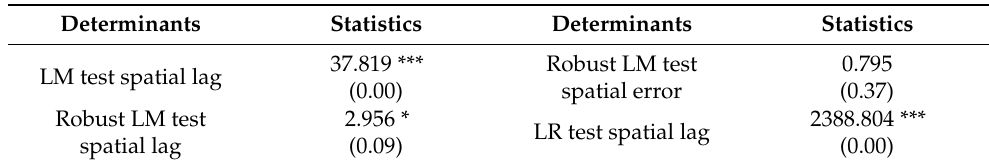
Table 3. Results of spatial econometric model